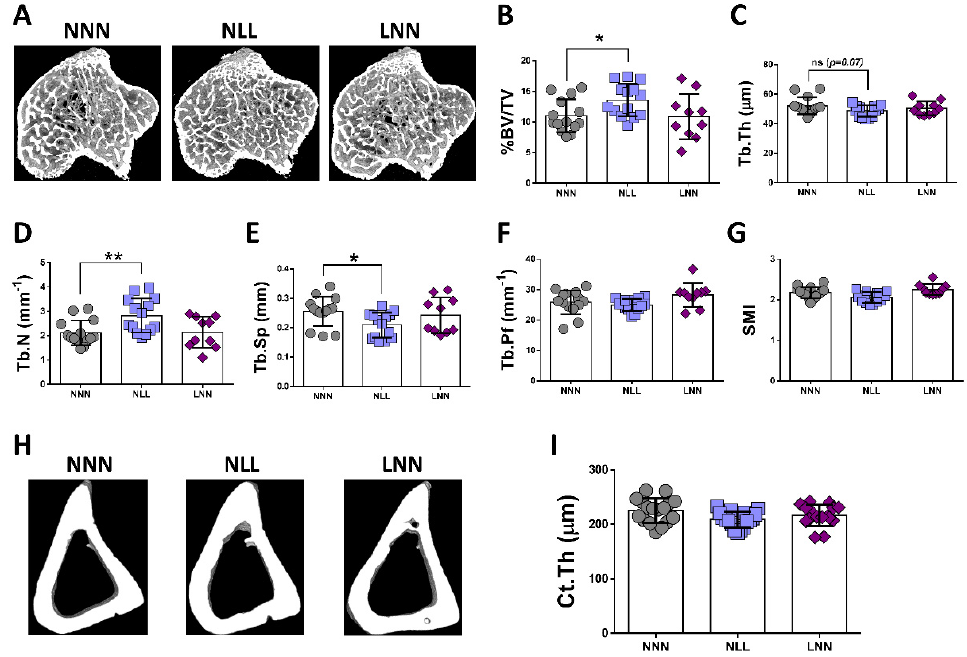
Figure 5. Micro-computed tomography morphological measurements in tibiae of 12-week-old mice. Representative images of the NNN, NLL and LNN groups ( A ) and quantification of bone volume to tissue volume ratio (%BV/TV) ( B ), trabecular thickness (Tb.Th) ( C ), trabecular number (Tb.N) ( D ), trabecular separation (Tb.Sp) ( E ), trabecular pattern factor (Tb.Pf) ( F ) and structural model index ( G ). For cortical bone ( H ), the cortical thickness ( I ) was measured and compared, where NNN served as the control group for all statistical comparisons; * p ≤ 0.05 and ** p ≤ 0.01, (mean ± SD; n = 10–14).